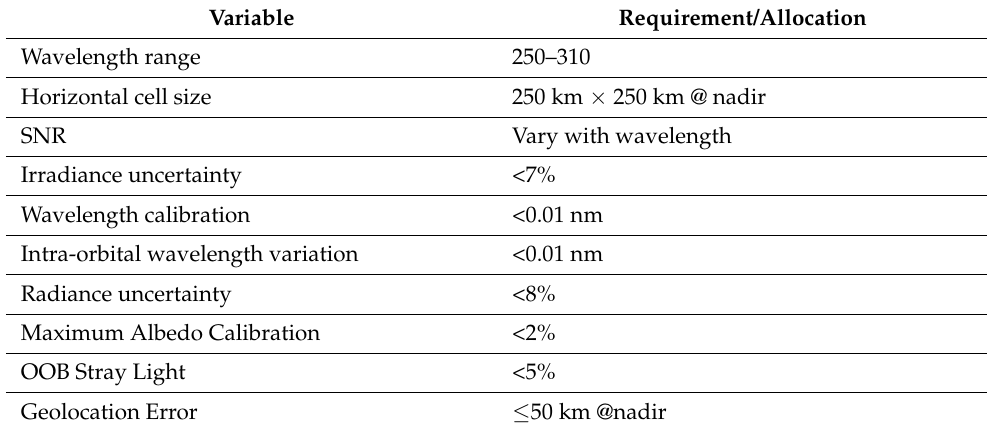
Table A4. SNPP OMPS NP SDR requirements or